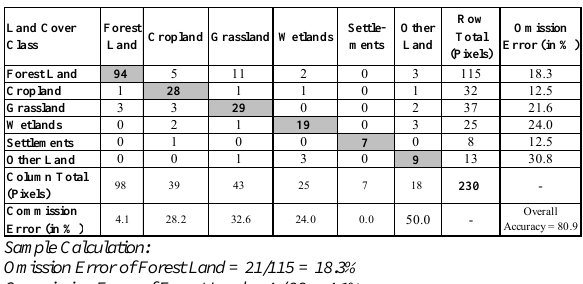
Table 1. Accuracy Assessment of LC Result from ALOS AVNIR-2